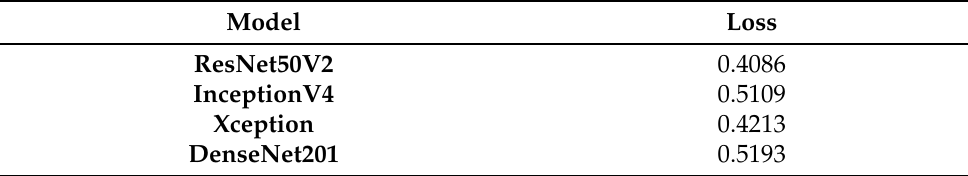
Table 6. The training loss from four transfer learning models.